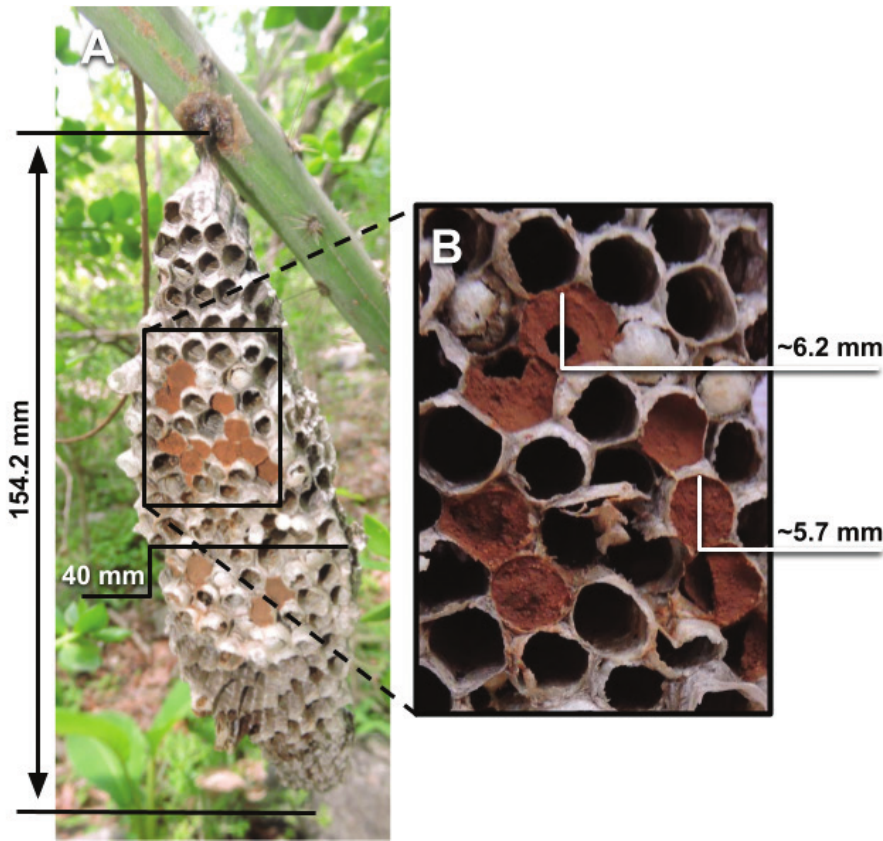
Figure 1. Polistinae’s abandoned nest A with sealed cells occupied B by juveniles of the Pachodynerus nasidens solitary species (Vespidae,